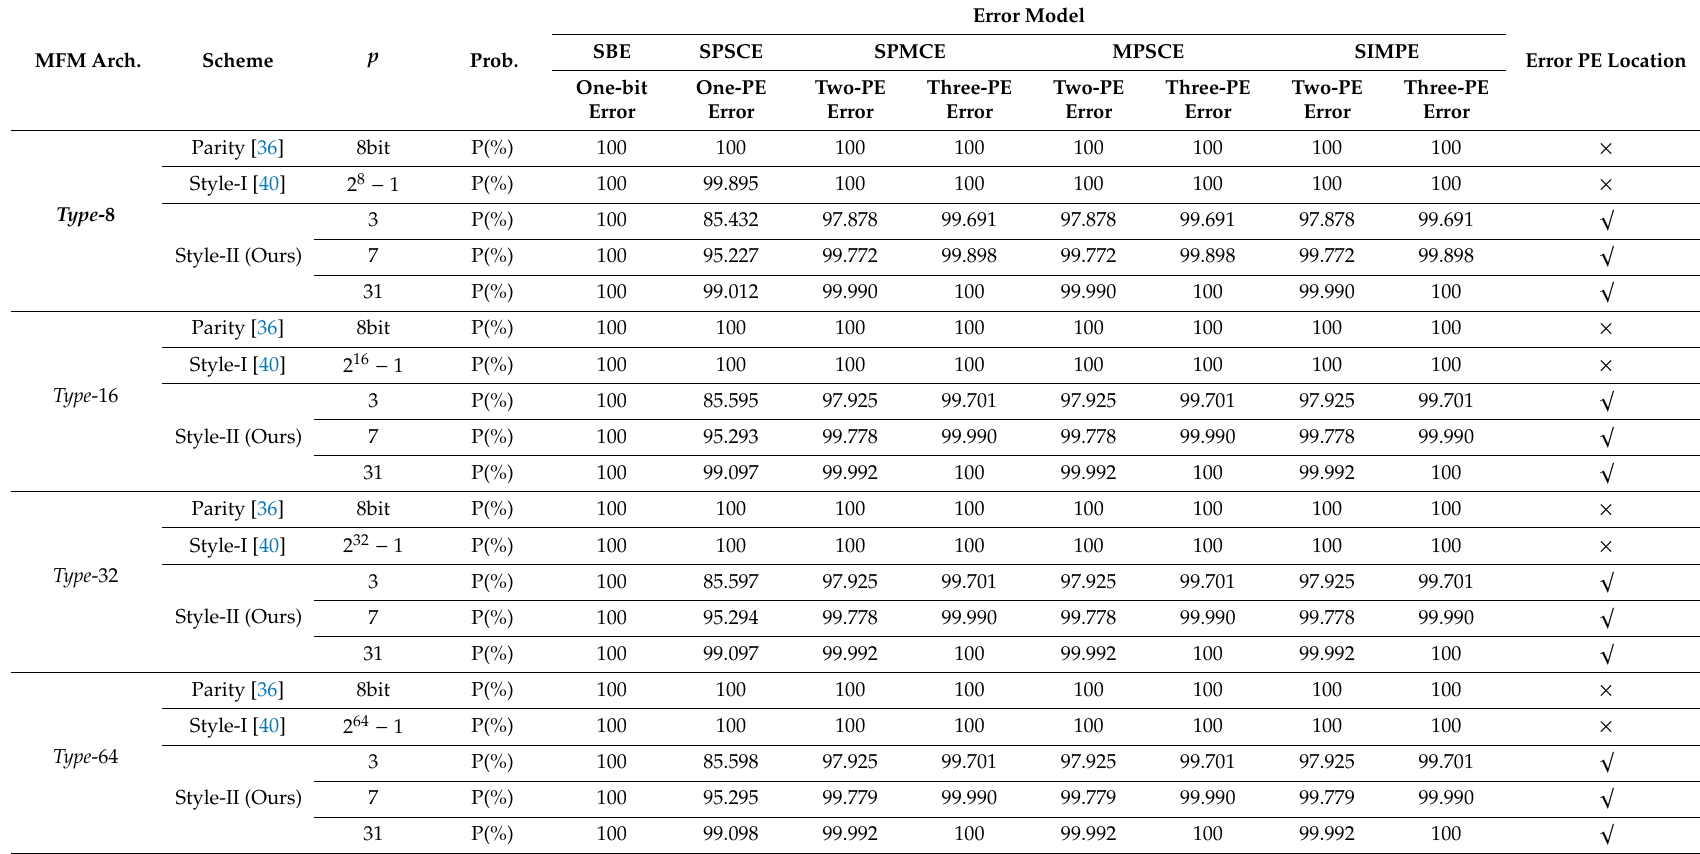
Table 2. The comparison of error detection